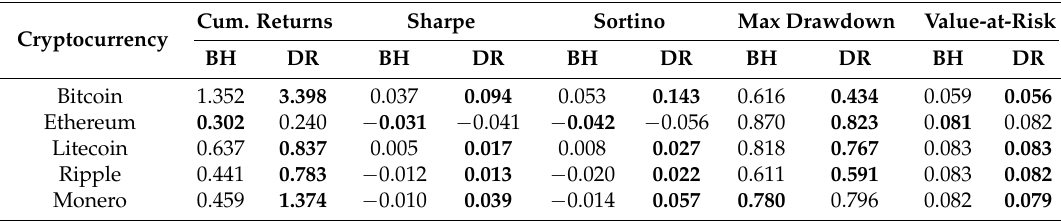
Table 2. Portfolio Performance